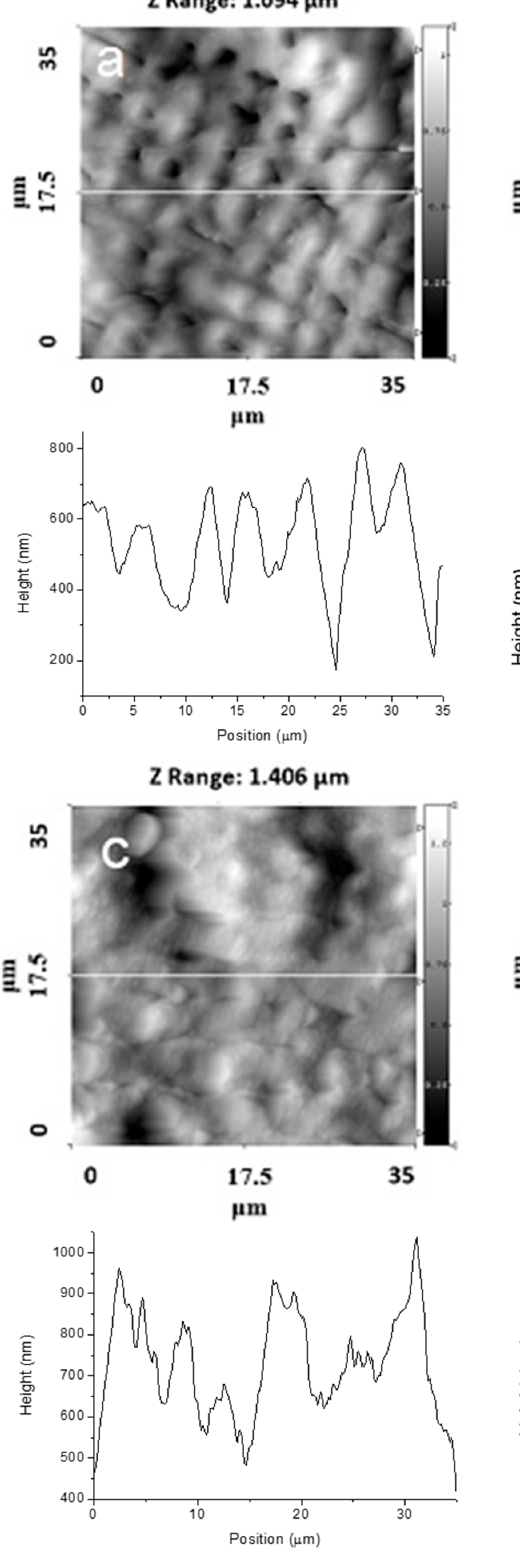
Figure 3. AFM images of the topographies of Ti samples with a crossed periodicity of approximately 4.5 µ m. ( a ) 35 × 35 µ m 2 ; ( b ) 5 × 5 µ m 2 without a HA film; ( c ) 35 × 35 µ m 2 ; and ( d ) 5 × 5 µ m 2 with a HA film.